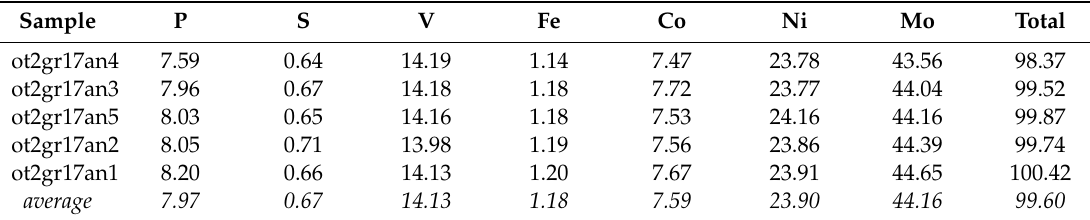
Table 1. Analytical data (wt.% of elements) for